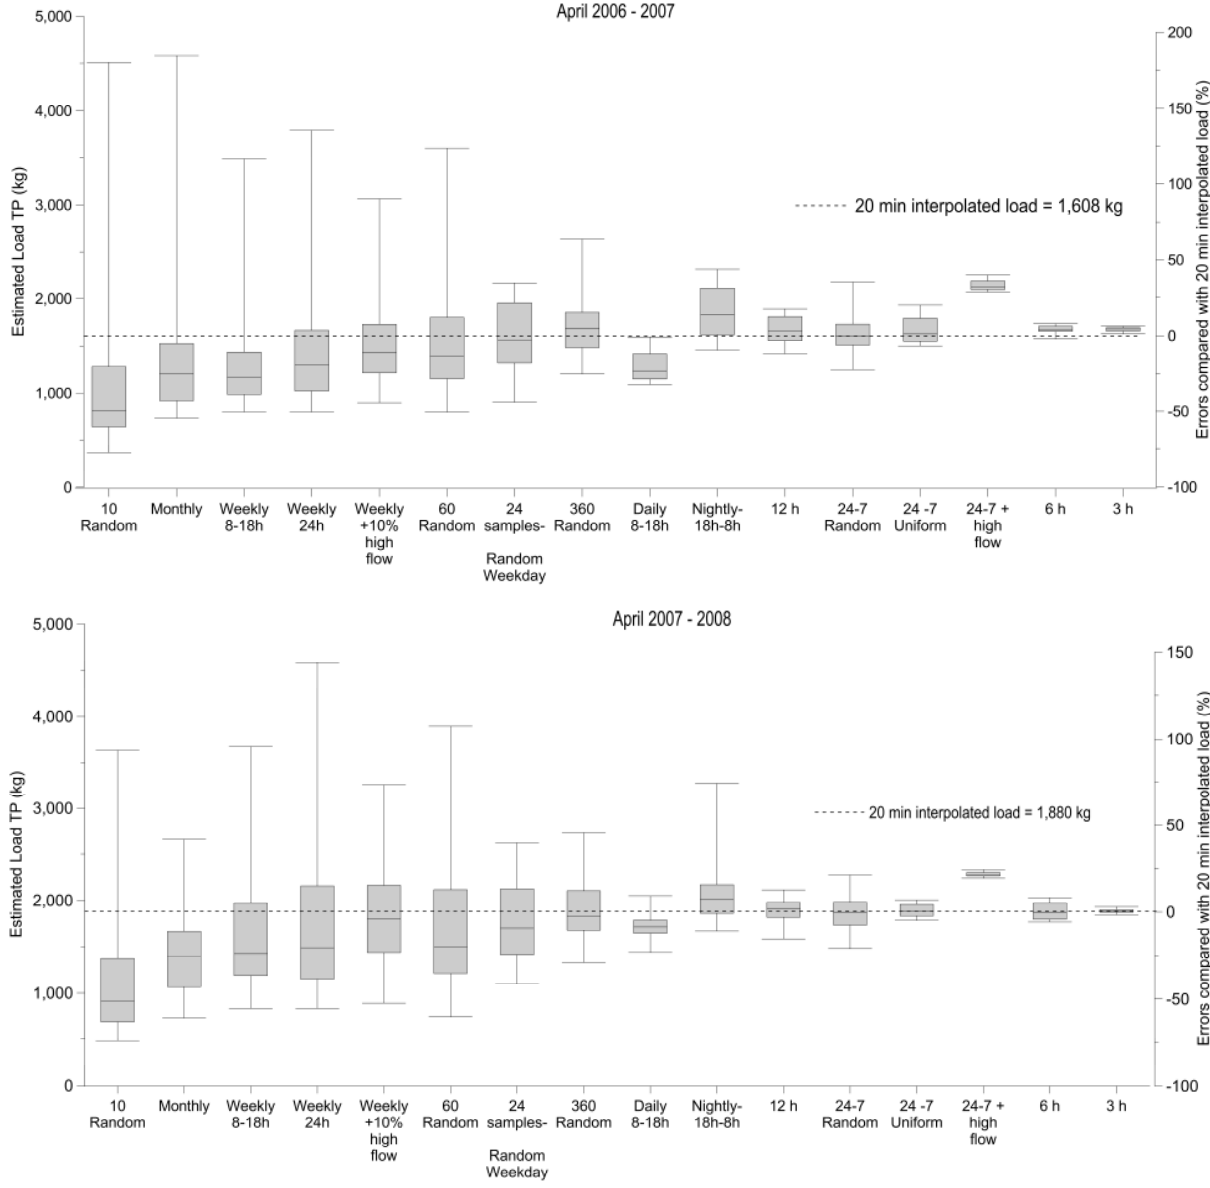
Fig. 1. Box whisker plots showing development of estimated loads (25th, 50th, 75th percentiles, maximum and minimum) using systematic and random sample sets from a decimated sub-hourly dataset of P concentration and discharge in 2006–2007 (a) and 2007–2008 (b)